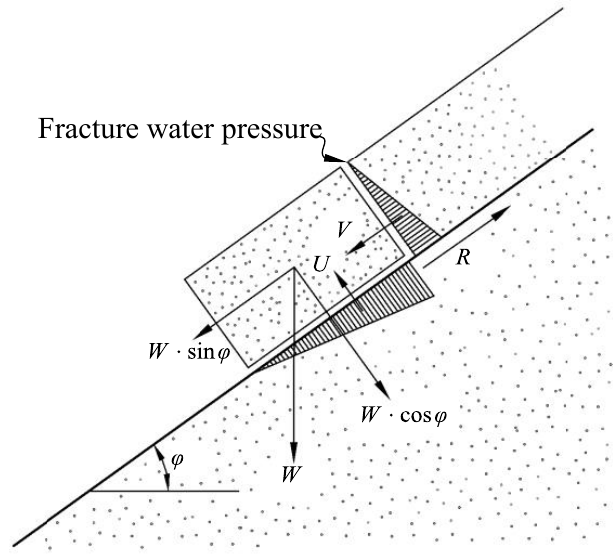
Figure 2. Diagram of fracture water pressure.